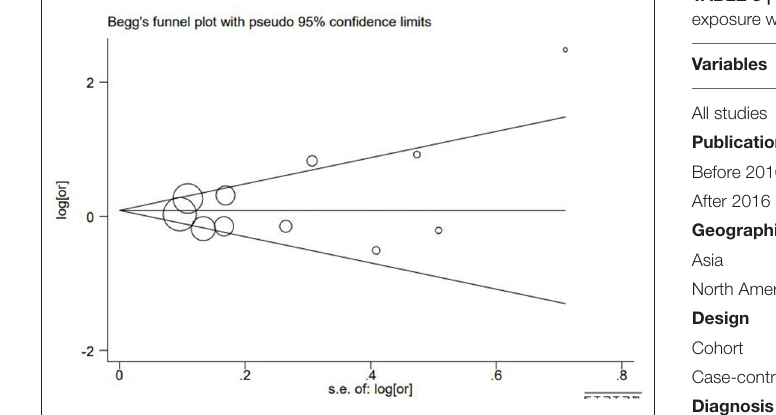
FIGURE 4 | Funnel plots of associations between cadmium exposure and the risk of GDM.